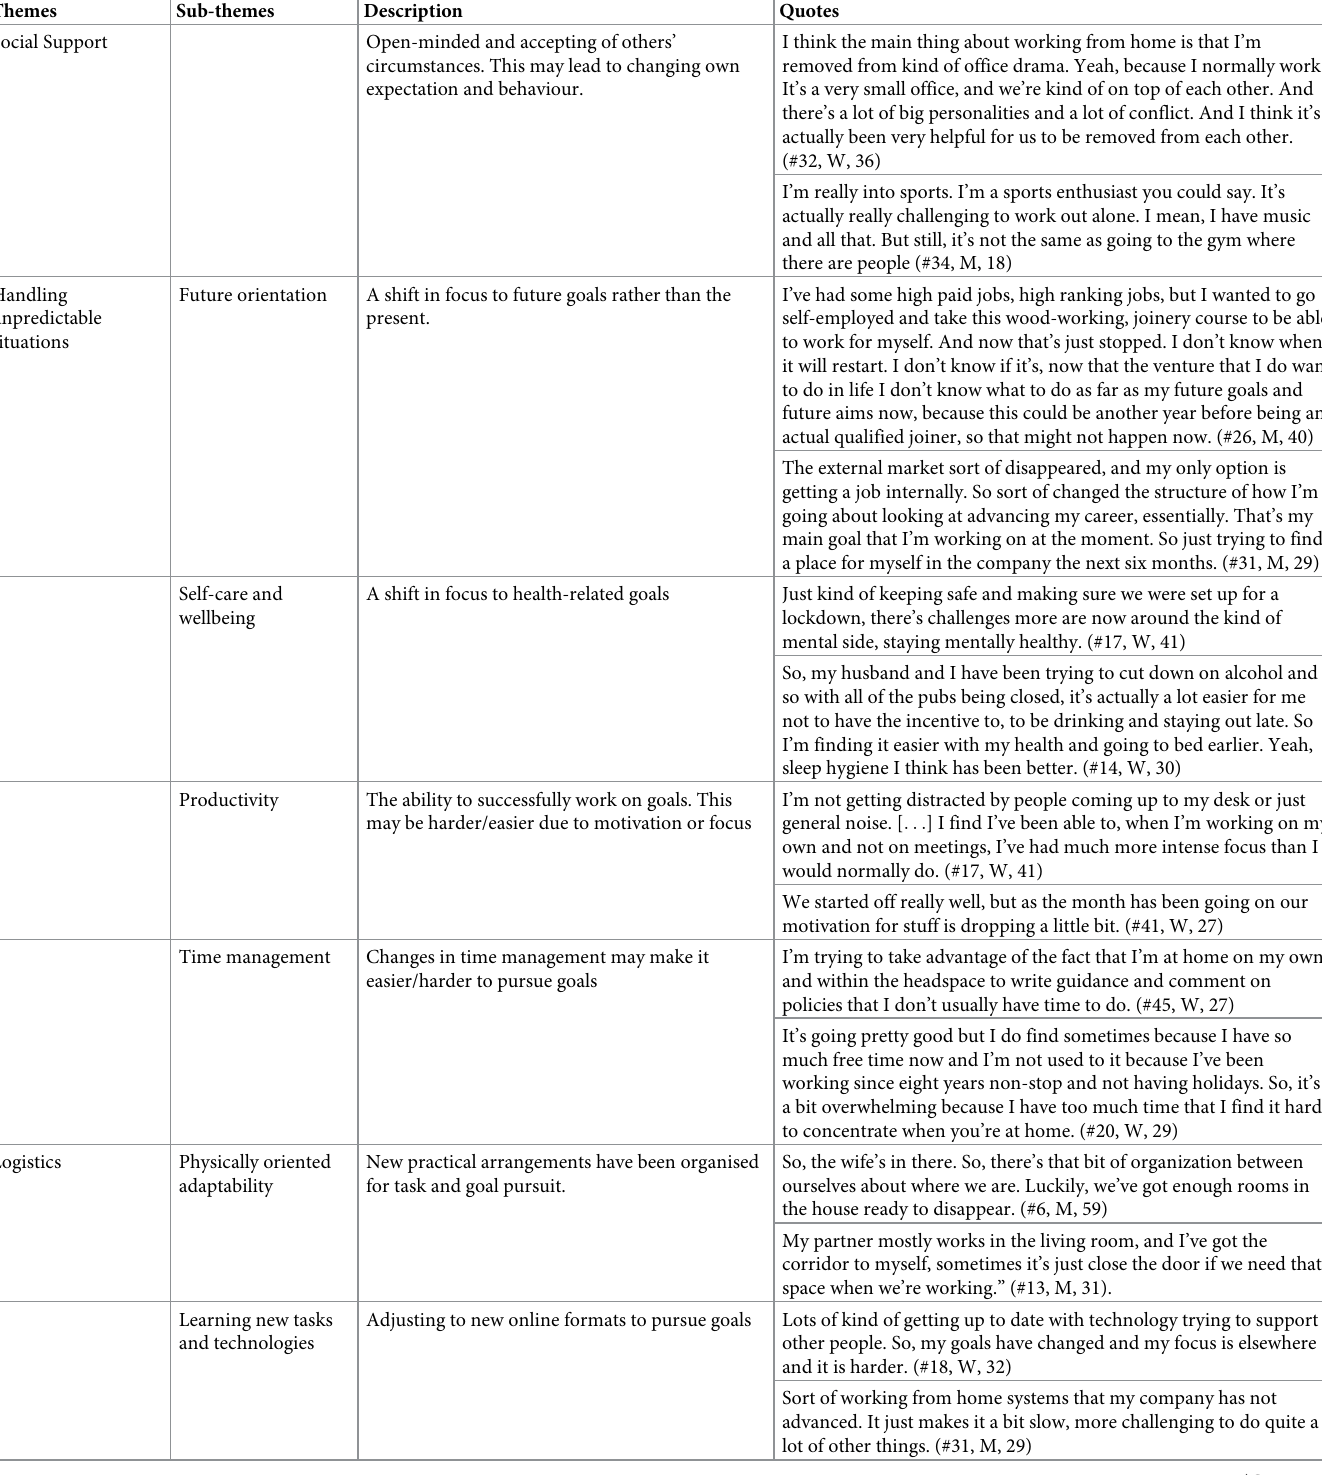
Table 2. Themes and subthemes with descriptions and representative quotes for changes in goal